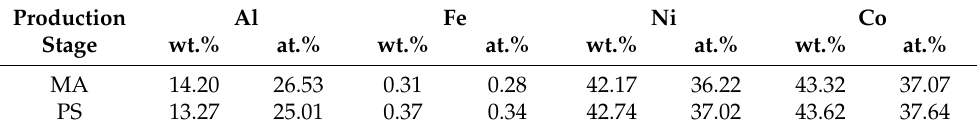
Table 2. Chemical compositions of Ni 36 Al 27 Co 37 powder after mechanical alloying and subsequent plasma spheroidization.